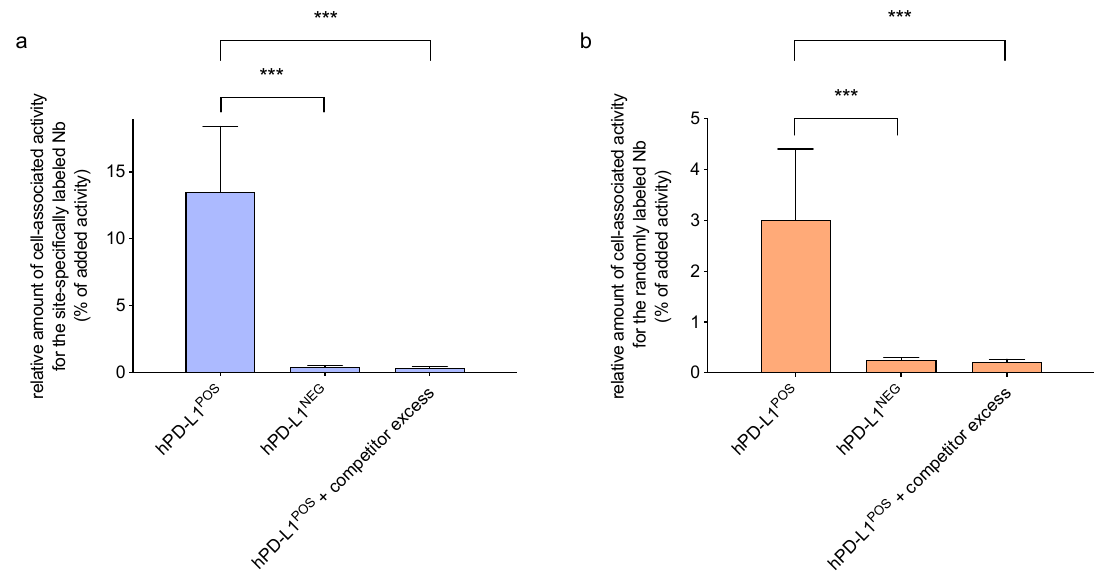
Figure 1. Relative amount of cell-associated activity of the ( a ) site-specifically and ( b ) randomly labeled [ 68 Ga]Ga-NOTA-(hPD-L1) Nbs on hPD-L1 POS cells at a 3 nM Nb concentration, or on hPD-L1 NEG cells, or in presence of an excess of unlabeled Nb as control groups. (***, p < 0.001).